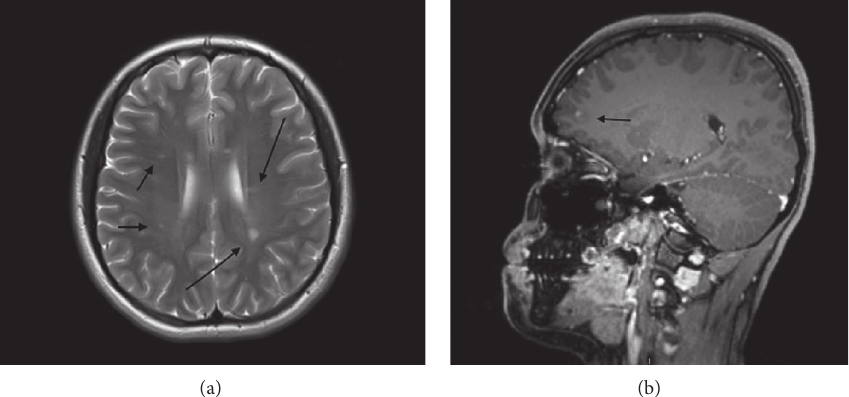
Figure 2: (a) There are multiple periventricular, subcortical, and juxtacortical white matter foci of T2 and FLAIR hypersignal in both cerebral hemispheres, brain stem, bilateral middle cerebellar peduncles, corpus callosum, and left anterior thalamus. (b) There is focal enhancement noted in the left peritrigonal white matter lesion.